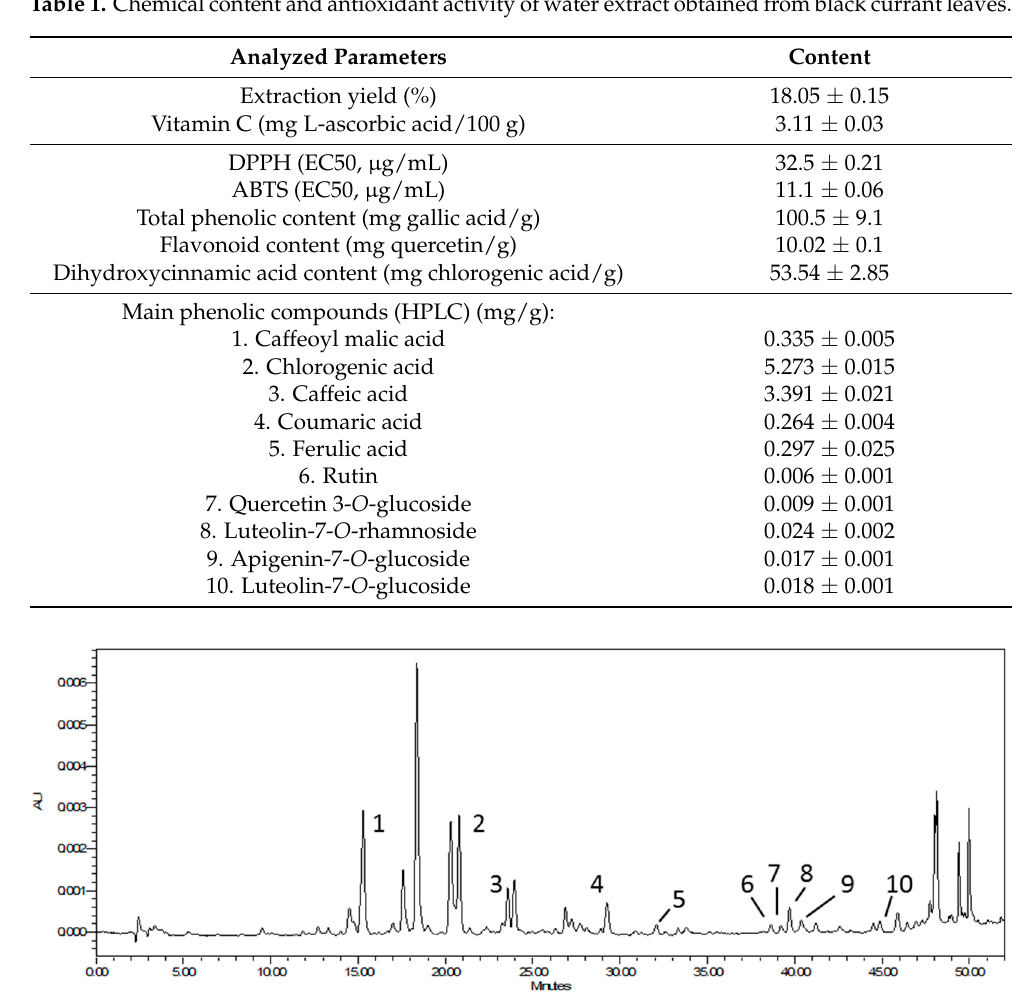
Table 1. Chemical content and antioxidant activity of water extract obtained from black currant leaves.